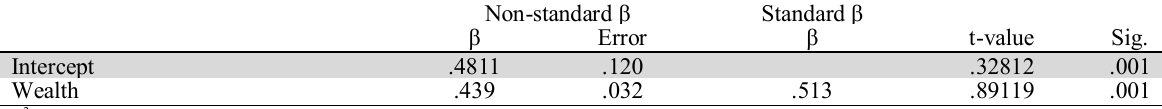
The summary of regression analysis for the second hypothesis